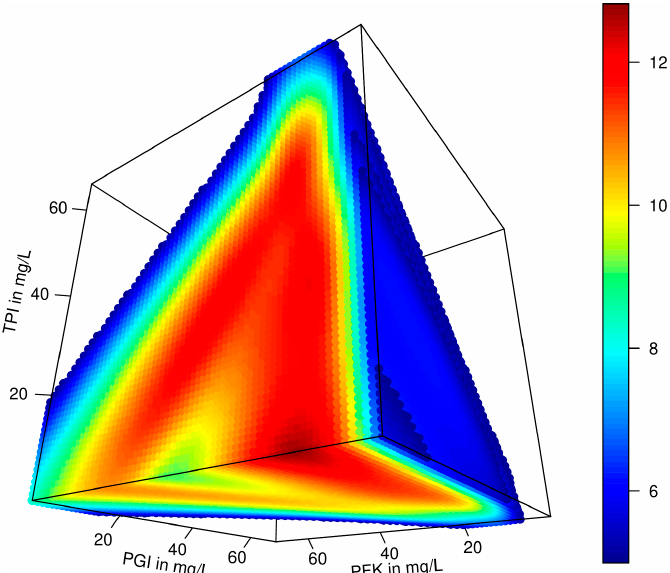
Figure 6. Three-dimensional visualization of flux predicted by an artificial neural network (ANN) for newly generated enzyme concentrations. The color gradient is from the lowest (blue) to the highest (red) predicted flux.